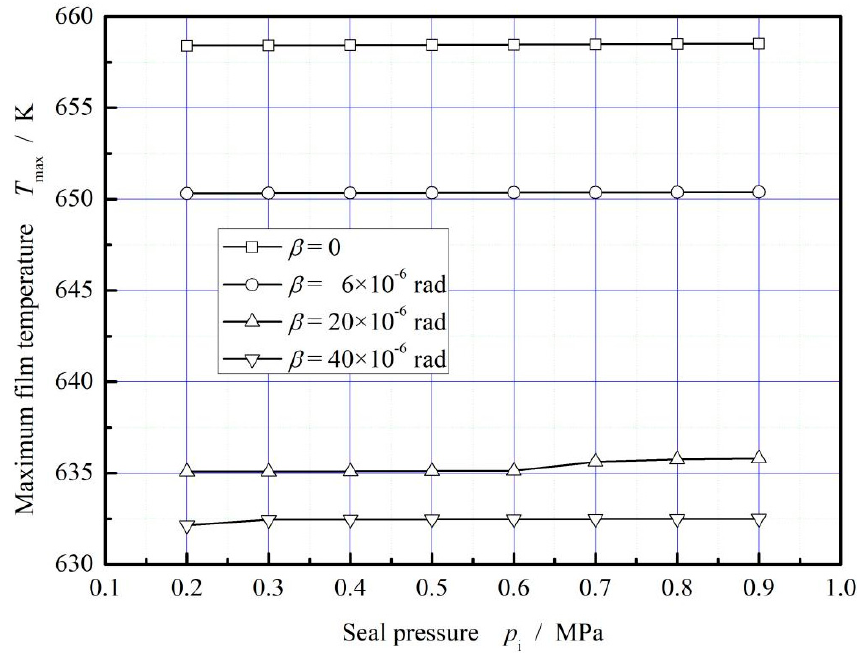
Figure 14. Influence of seal pressure on the maximum temperature of gas film. ( ω = 3.0 × 10 4 r/min, T in = 580 K, T out = 380 K).